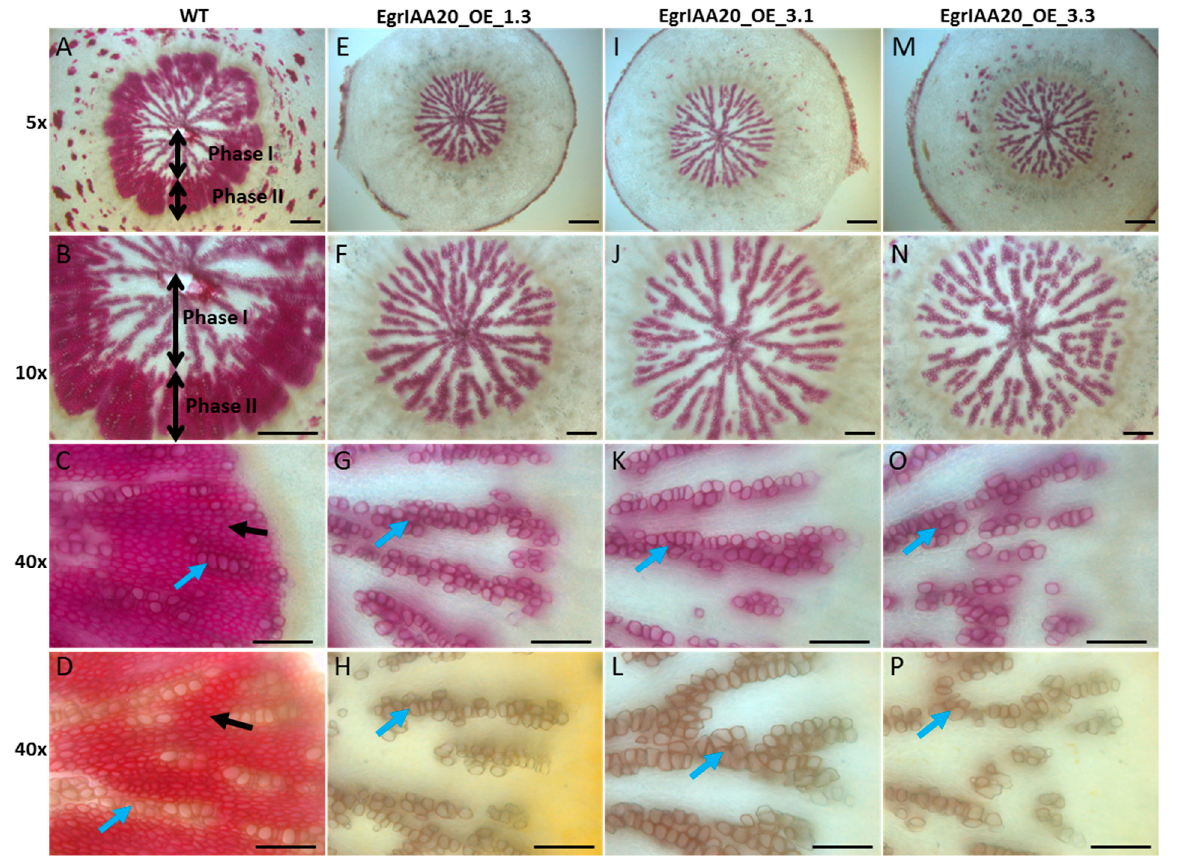
Figure 8. EgrIAA20 overexpression specifically inhibits the lignification of fibers in secondary but not primary fibers nor any tracheary elements in Arabidopsis hypocotyl. Left panel ( A – D ) shows cross section of hypocotyl of wild-type control, 5×, 10×, and 40× objective image for the first raw, second and third raw, respectively, using Phloroglucinol-HCl staining, which stains the lignin polymers in the SCW of xylem cells into red-purple; the last raw was 40× objective observation image stained with Maüle method, which stains the fiber cells into bright red color, indicated by black arrow, and stains the vessels in to brown, indicated by blue arrow. The corresponding hypocotyl cross sections from three independent EgrIAA20 overexpressing lines are shown in the middle and right panels: EgrIAA20_OE_1.3 (strong line, middle left panel, ( E – H )), EgrIAA20_OE_3.1 (strong line, middle right panel, ( I – L )), EgrIAA20_OE_3.3 (weak line, right panel, ( M – P )). Phase I growth region and phase II growth region are indicated by double-arrow lines in wild type cross section. Blue arrows indicate secondary vessel cells (vessel II); black arrows indicate secondary fiber cells (Fiber II). The first to third raw used Phloroglucinol-HCl staining, the bottom raw used Maüle staining methods. For 5× and 10× images, scale bar = 200 µm, and for 40× images, scale bar = 50 µm.